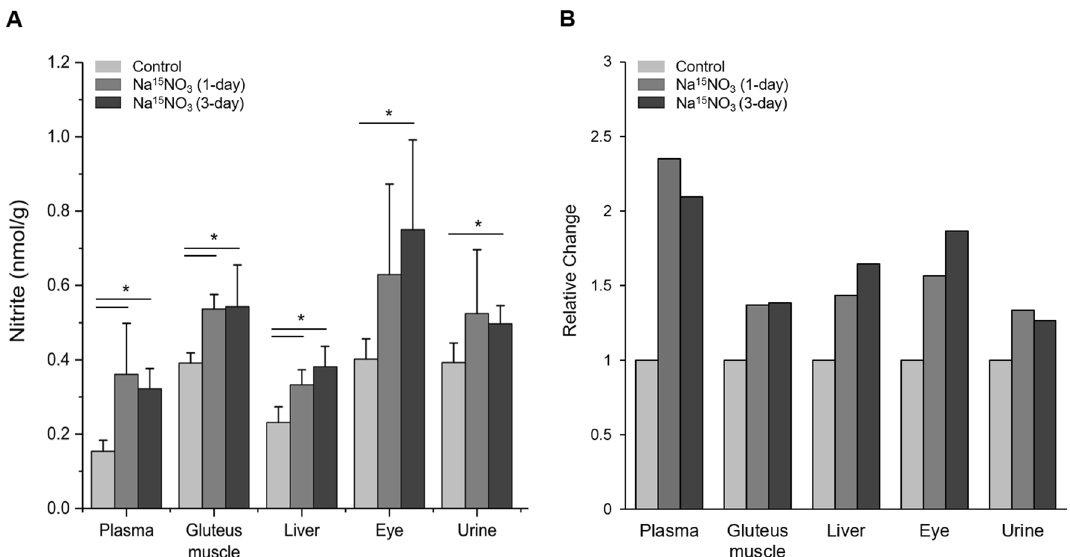
Figure 2. Total nitrite concentrations in rat tissues. ( A ) Tissue samples were homogenized by a rotary homogenizer 40 , then centrifuged (17,000 g, 30 min) after mixing with methanol for deproteinization. The supernatant was used for nitrite content measurement using a standard chemiluminescence method with triiodide. Data are plotted as average ± standard deviation (n = 4 ~ 6, * p < 0.05). ( B ) The change in each organ at 1-day and 3-day Na 15 NO 3 supplementation (1 g/L) relative to